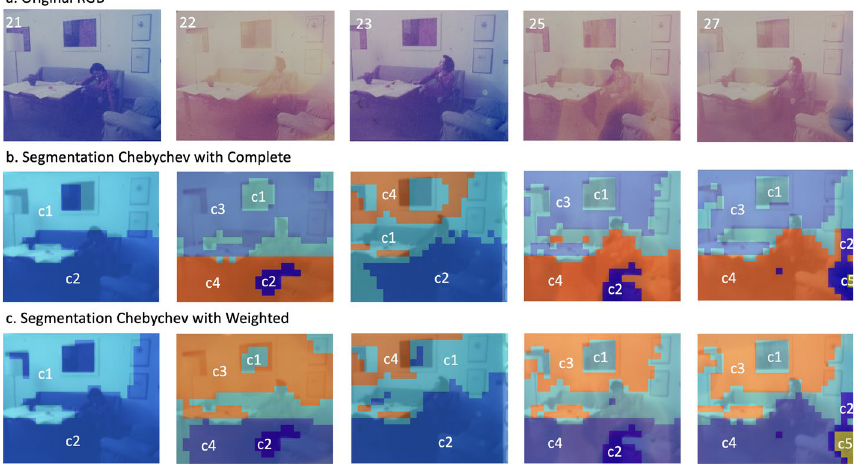
Fig. 9 Segmentation results varying the agglomeration method, using a grid size of 50 Euclidean distance